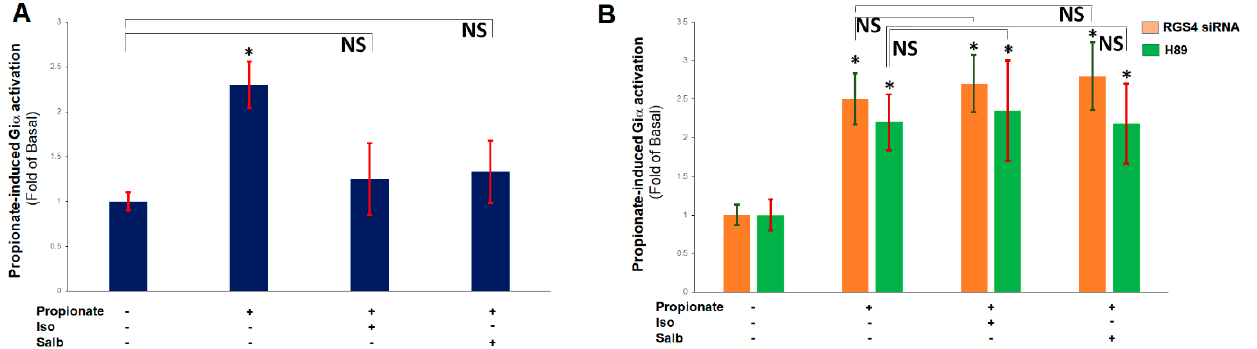
Figure 3. β ARs negatively regulate FFAR3 signaling via RGS4 and PKA in cardiac myocytes. ( A ) Gi α activation in native H9c2 cells treated with 1 mM propionate, 10 µ M isoproterenol (Iso), 10 µ M salbutamol (Salb), or a combination thereof. * , p < 0.05, vs. basal (no treatment); NS: Not significant (vs. basal-No treatment) at p = 0.05; n = 3 independent measurements (in duplicate) per condition. ( B ) Gi α activation in RGS4-depleted (RGS4 siRNA) or in native H9c2 cells pre-treated with 10 µ M H89 (H89), in response to 1 mM propionate alone, or to 1 mM propionate in the presence of 10 µ M isoproterenol (Iso) or 10 µ M salbutamol (Salb). * , p < 0.05, vs. respective basal (no treatment); NS: Not significant (vs. respective propionate alone) at p = 0.05; n = 3 independent determinations (in duplicate) per condition per cell clone.